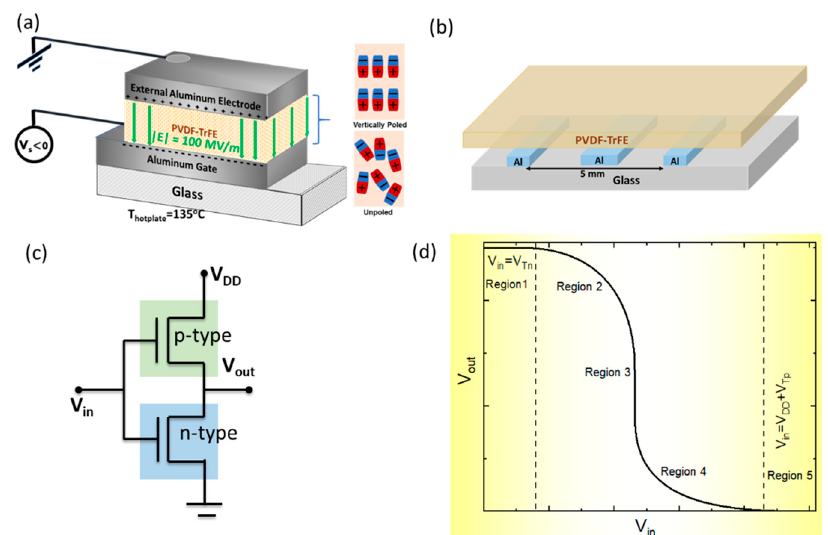
Figure 1. ( a ) Schematic of vertical poling the PVDF-TrFE layer where the dipoles are oriented in a vertical direction. ( b ) Layout of the electrodes below the PVDF-TrFE layer for texture-poling condition. ( c ) Schematic of a voltage inverter comprising a p-field-effect transistor (FET) and an n-FET. ( d ) The five different regions of operation of an inverter circuit. These regions are discussed in the text.